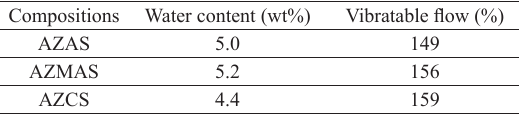
Table 4. Water demand and vibratable flow obtained for the evaluated